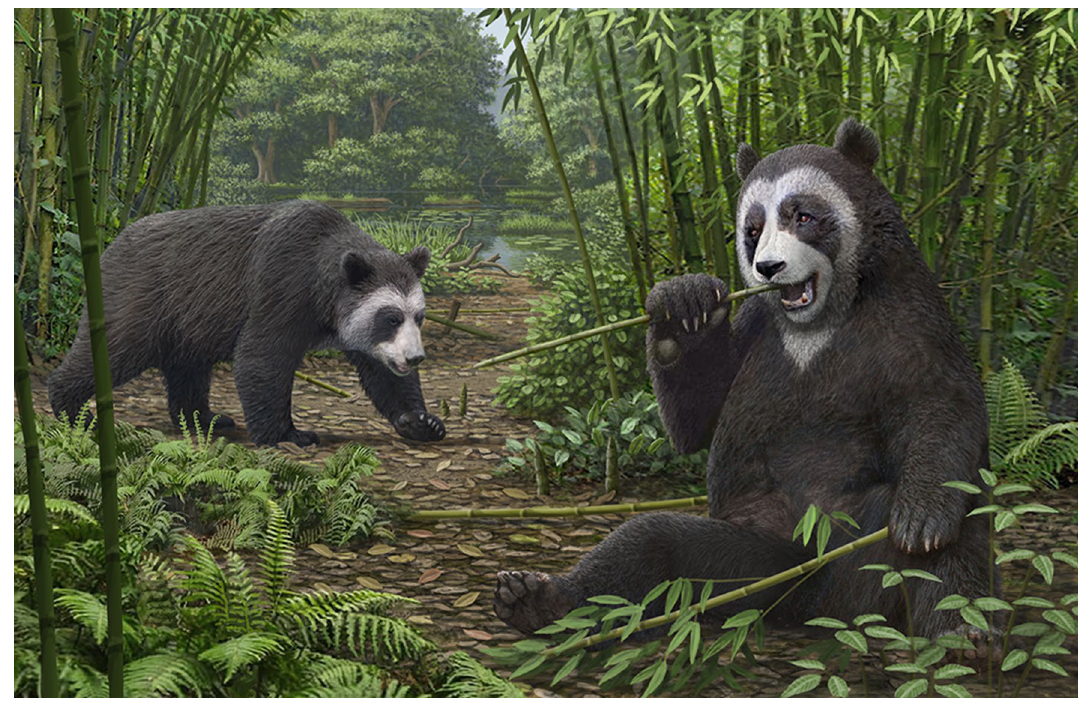
Figure 8. An artist reconstruction of Ailurarctos from Shuitangba. The grasping function of its false thumb (shown in the right individual) has reached to the level of modern pandas, whereas the radial sesamoid may have protruded slightly more than its modern counterpart during walking (seen in the left individual). Art by Mauricio